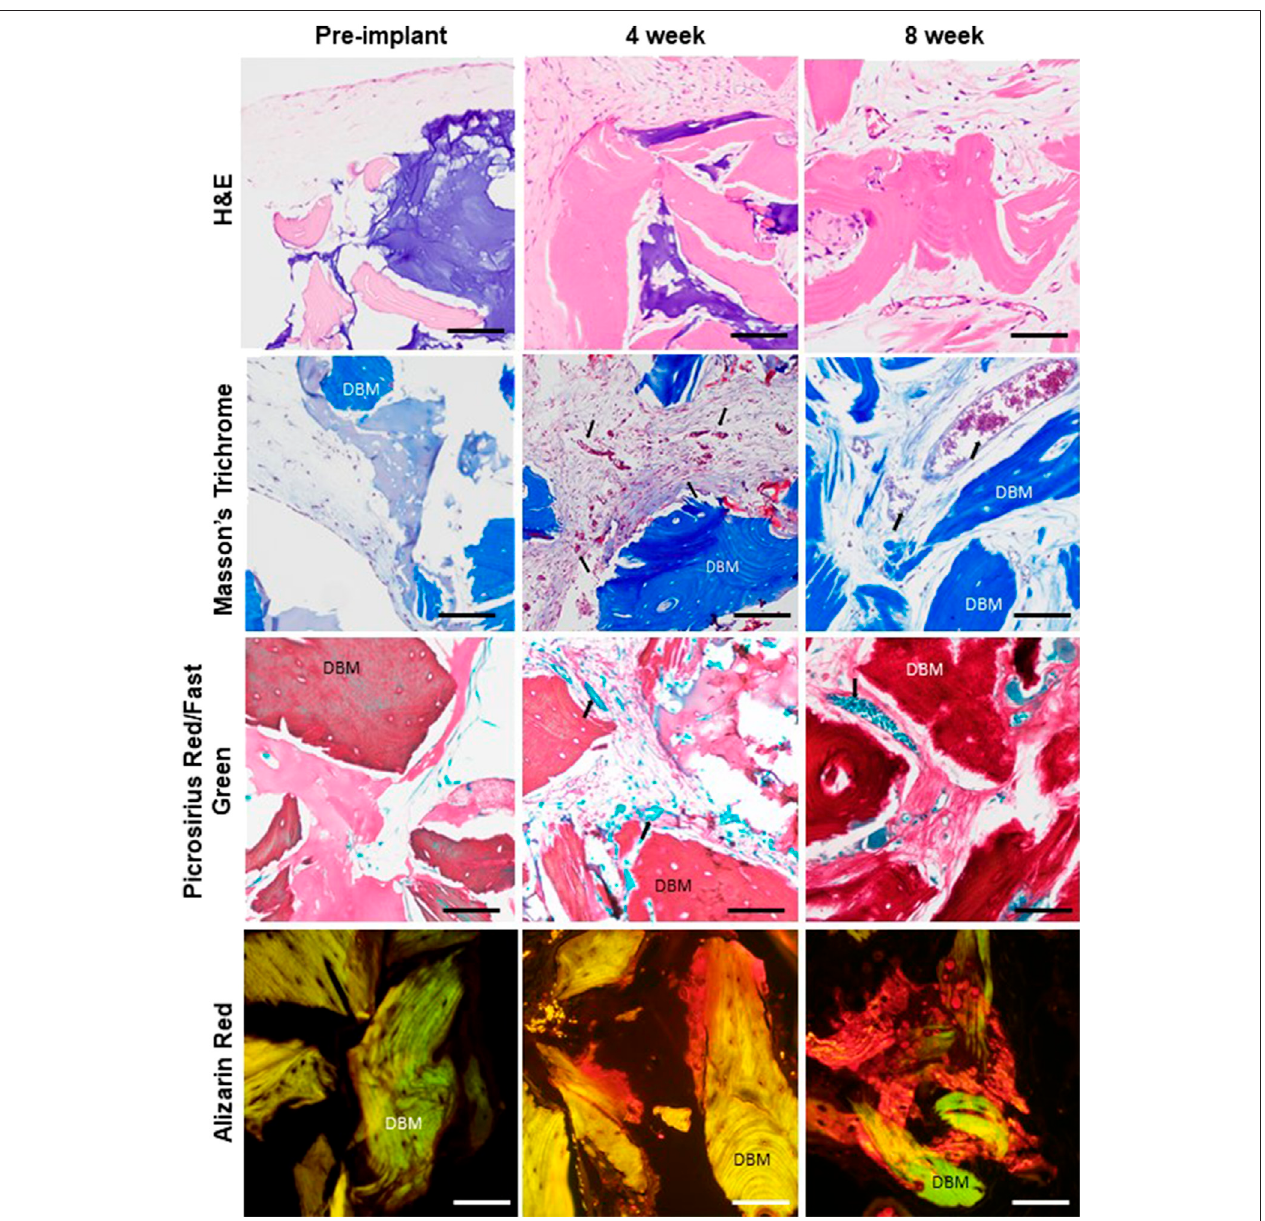
FIGURE 4 | Dynamic remodeling and mineralization of the graft tissue environment. Comparison of representative histology of graft tissue prior to implant (after 3 weeks of in vitro culture), at 4-week explant, and at 8-week explant showing tissue organization (H&E), collagen composition and structure (Masson ’ s trichrome and picrosirius red), and mineralization (alizarin red, AR). Red blood cells (arrows) are visible in vessel pro fi les in the 4- and 8-week samples. Scale bar for all images equals 100 µm. 4 and 6 week respective graft numbers: H&E 682, 677; PR/FG 681, 678; Masson ’ s 681, 677; AR 681, 678.